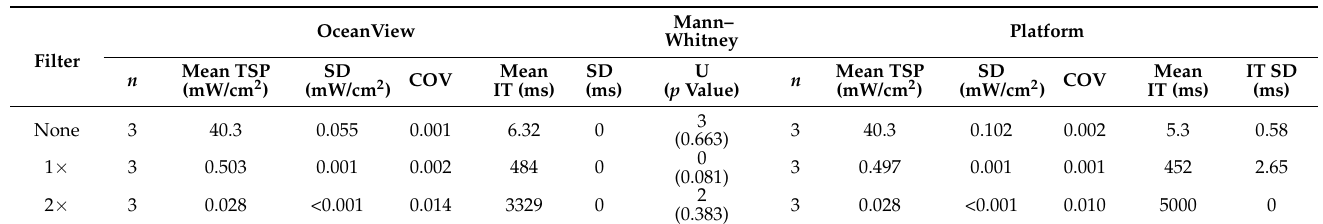
Table 2. The mean total power average, standard deviation, coefficient of variation, integration time (IT) mean and standard deviation, and the results of the Mann–Whitney test comparing the TSP for the OceanView vs. platform-controlled data.